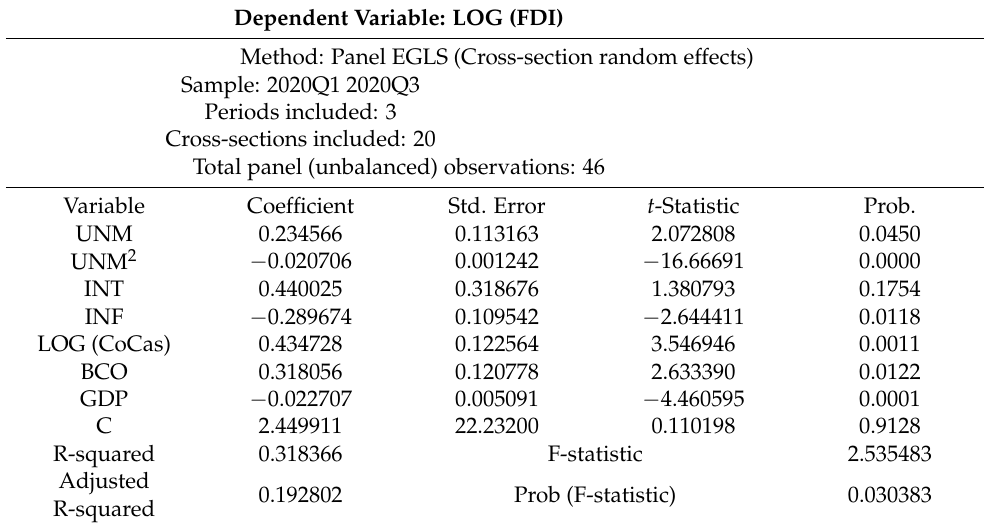
Table 4. Random effects model